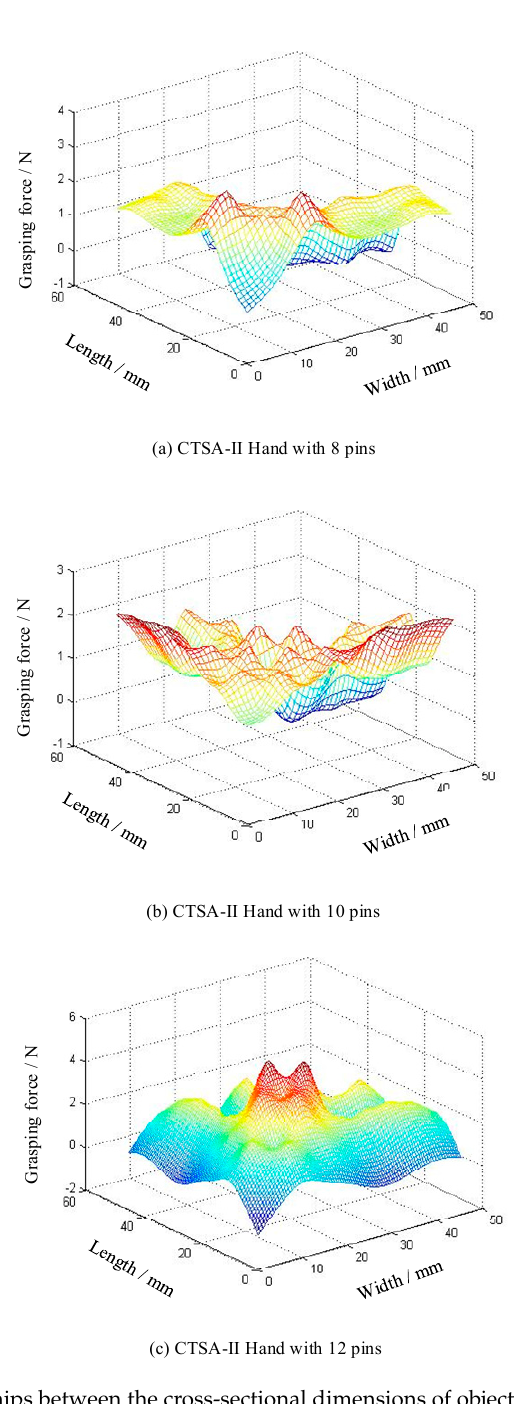
Figure 23. The relationships between the cross-sectional dimensions of objects and the grasping force.